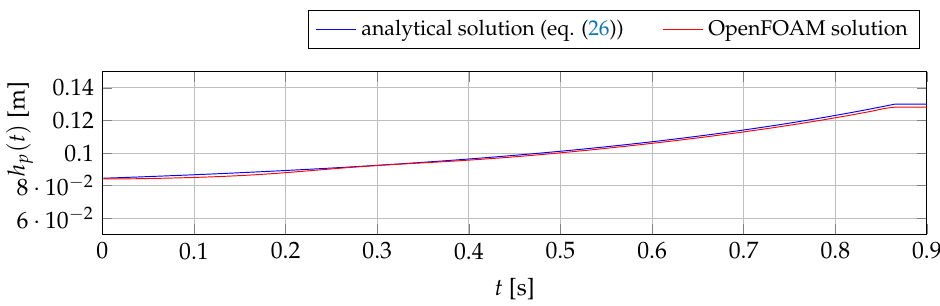
Figure 5. The melt height at the plunger boundary; analytical model according to [43] vs. result of the numerical